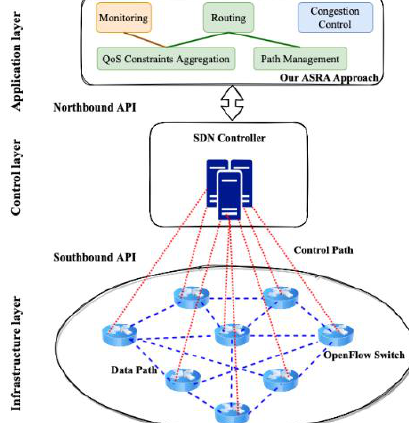
Fig. 1. Our designed architecture based on SDN: an